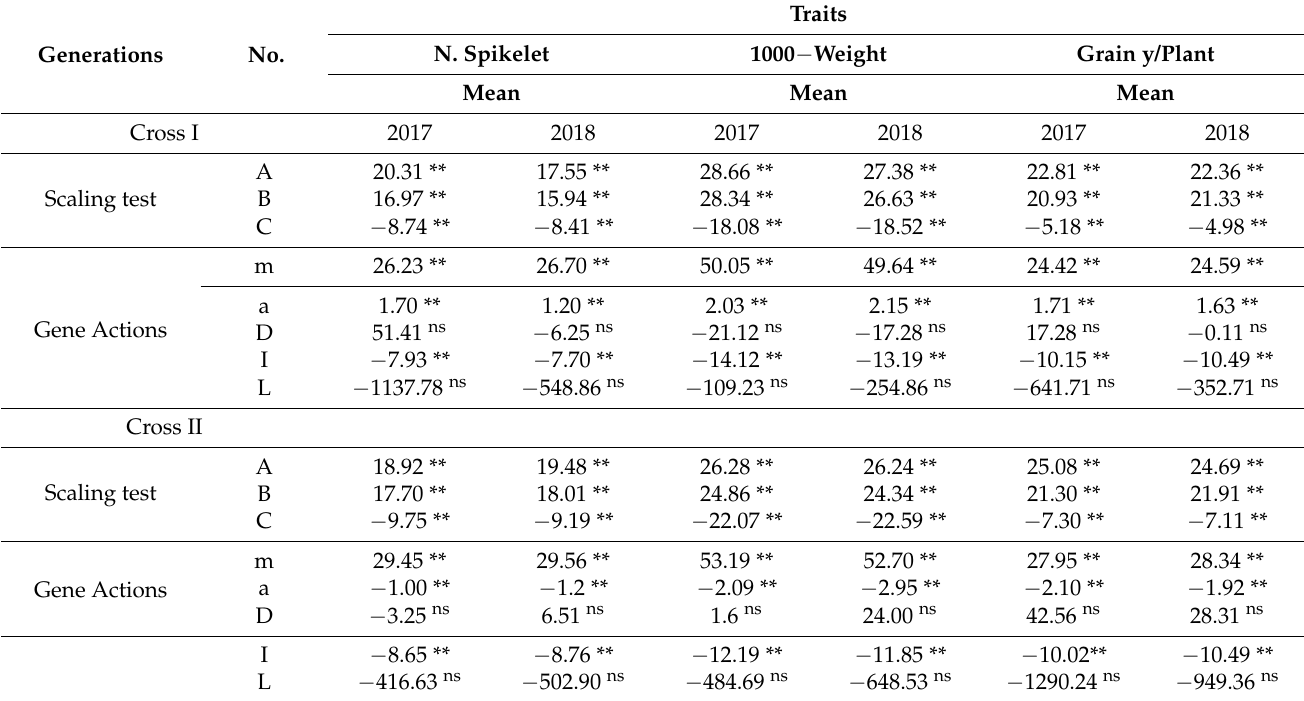
Table 4. Scaling test, gene actions and epistasis for three quantitative traits in two crosses of wheat over two seasons.